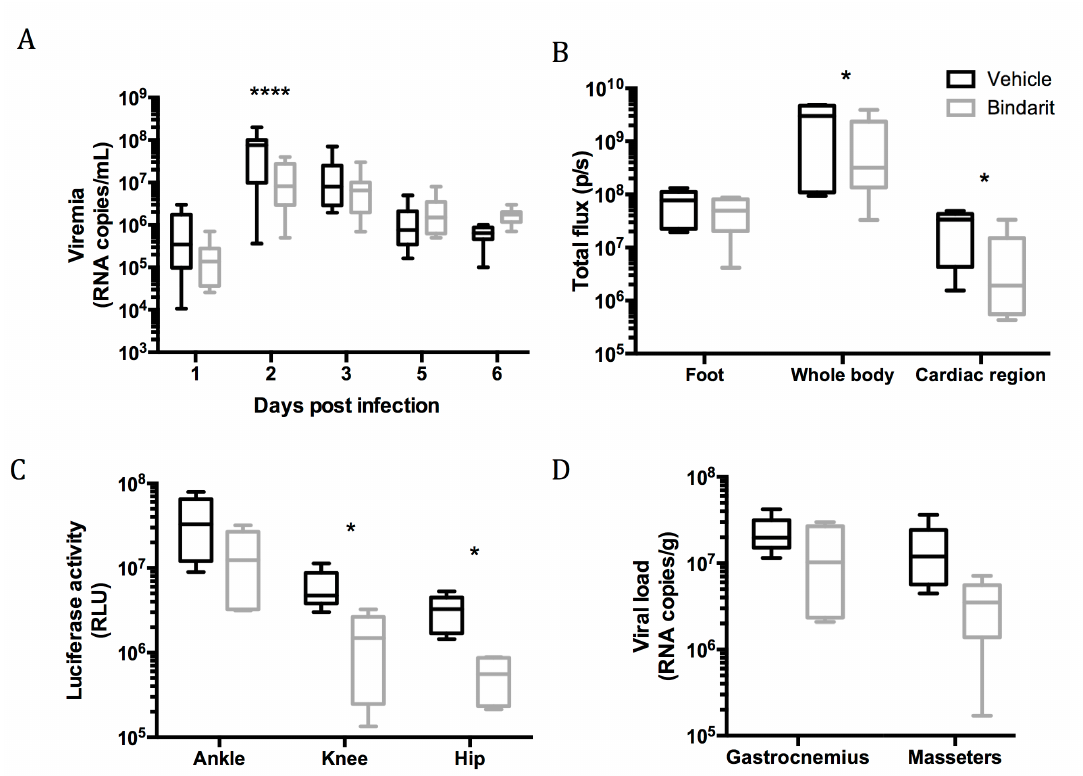
Figure 4. Bindarit e ff ect on viral dissemination and replication. Mice were treated with Bindarit (grey) or vehicle treated (black) 6 h prior to infection with 10 3 pfu of RRV-NLuc. Mice were monitored for the indicated parameters. Data were pooled from two independent experiments ( n = 8). ( A ) Viremia in peripheral blood; ( B ) in vivo imaging at 5 dpi, quantification of the bioluminescent signal in the inoculated foot, cardiac region and whole body of the infected mice; ( C ) luciferase activity in the joints of the inoculated limb at 6 dpi (mean background signal 1.7 10 4 RLU) and ( D ) RNA loads in muscles at 6 dpi ( n = 5). * = p < 0.05, **** = p < 0.0001, two way